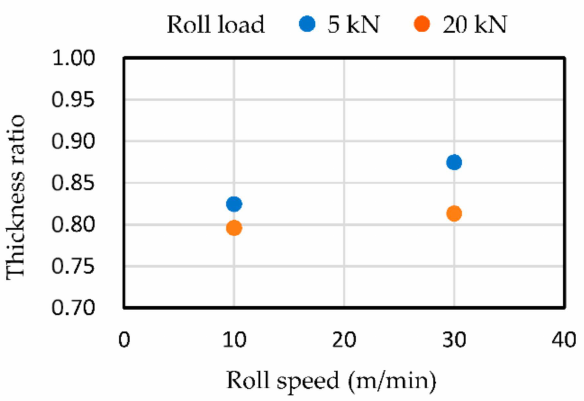
Figure 10. Ratio of strip thickness using mild steel and copper rolls. The thickness ratio is defined as (thickness of strip cast using mild steel rolls)/(thickness of strip cast using copper